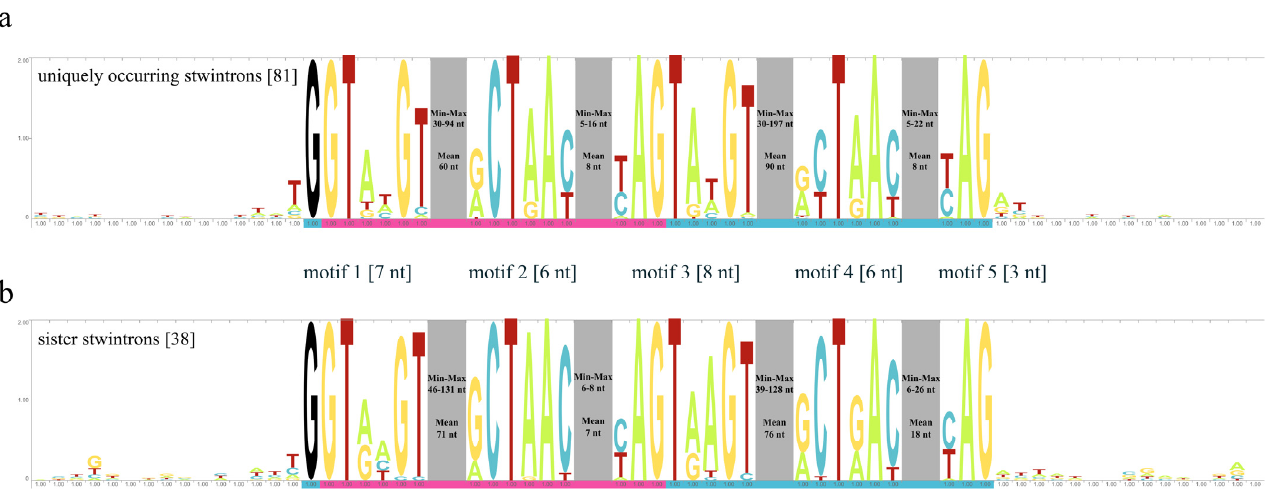
Figure 4. Sequence Logo of the stwintron–exon junctions of the 81 uniquely occurring [D1,2] stwintrons in Hypoxylon sp. CO27-5 compared with that of the group of 38 full-length sister and sheared sister stwintrons described in [25]. ( a ) The Logo for the group of newly described, uniquely occurring (UO) stwintrons (81 sequences) without sequence similarity of note, while ( b ) shows the Logo for the sequence-related sister stwintrons (38 sequences, including two EC38-specific sister stwintrons). Logos visualise the extent of nt conservation in multiple sequence alignments and highlight patterns of conservation. The core of the multiple sequence alignments consists of the concatenated sequences of the five consensus sequence motifs at the splice sites and the canonical BP sequences of the internal and external introns within the [D1,2] stwintron (together 30 nt: see also Figure 2). At each end of the five concatenated stwintron sequence motifs, the 15 nt of the exonic sequences directly bordering the stwintron were added to the input DNA. The sequences of the internal intron are indicated by the magenta bar underneath the Logo, and the sequences of the external intron are indicated by the turquoise bar. The ubiquitous black G (position 16) is the G 1 of the split donor of the external intron of the stwintrons in [D1,2] sequence motif 1. The four spacer sequences between the five conserved [D1,2] sequence motifs are not drawn to scale; these se- quences lack similarity amongst the 81 UO stwintrons. The spaces (grey boxes) were used to sum- marise details about the length of the spacers between the donor and canonical BP sequence ele- ments, and the length of the spacers between canonical BP sequence elements and the acceptors (i.e., the minimum, maximum and mean length) of these four intronic spacer sequences are given.